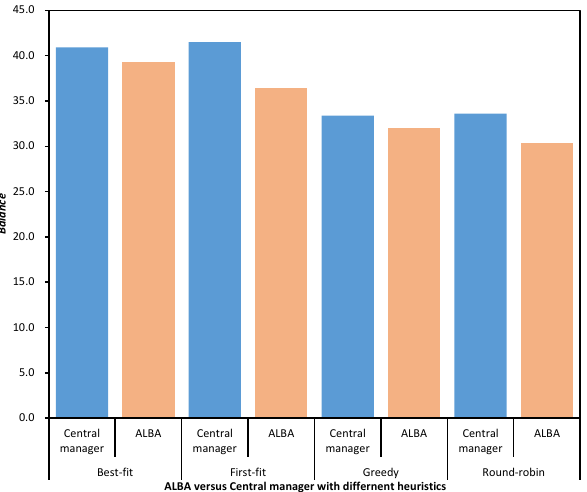
Figure 4. Load balancing comparison of ALBA and Central managers.